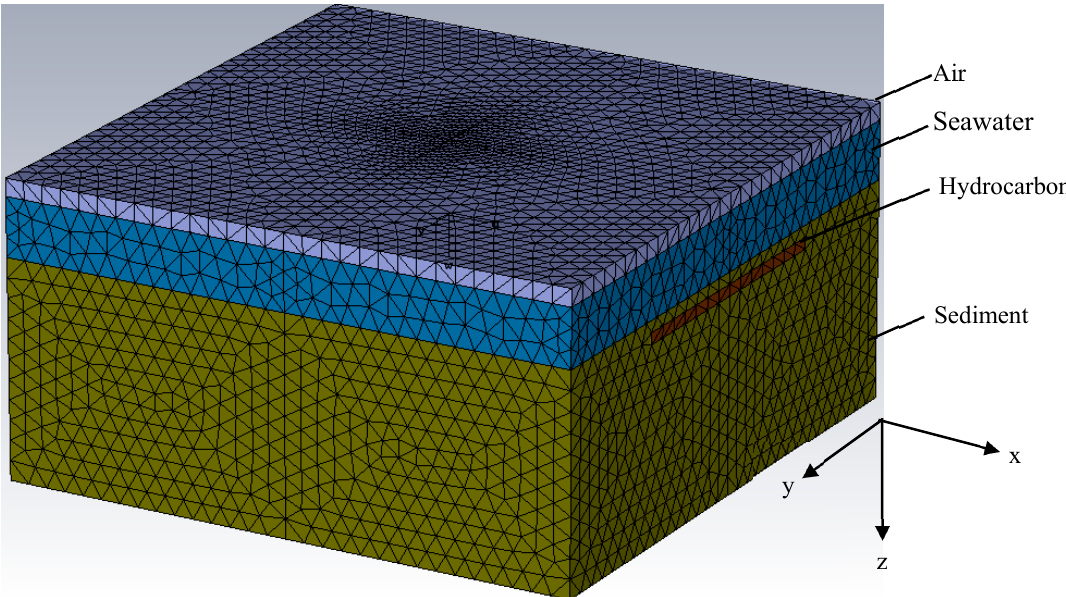
Figure 3. Mesh view of the 3D SBL model at hydrocarbon depth of 250 m replicated by CST software. Both background and hydrocarbon layers are set as isotropic. The hydrocarbon layer is designed with length (x) of 10,000 m, width (y) of 5000 m and height (z) of 200 m.